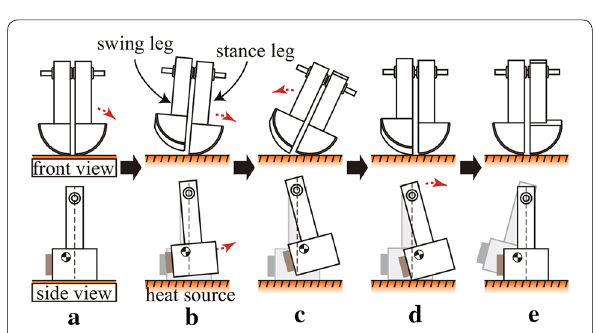
Fig. 3 Walking principle. a Walker stands upright on a hot surface, b right leg is lifted up and the leg behaves as a pendulum. Left leg supports the body, c the body swings back toward upright posture, d swing leg lands on the hot surface, e legs switch their roles (From [8], ©2015